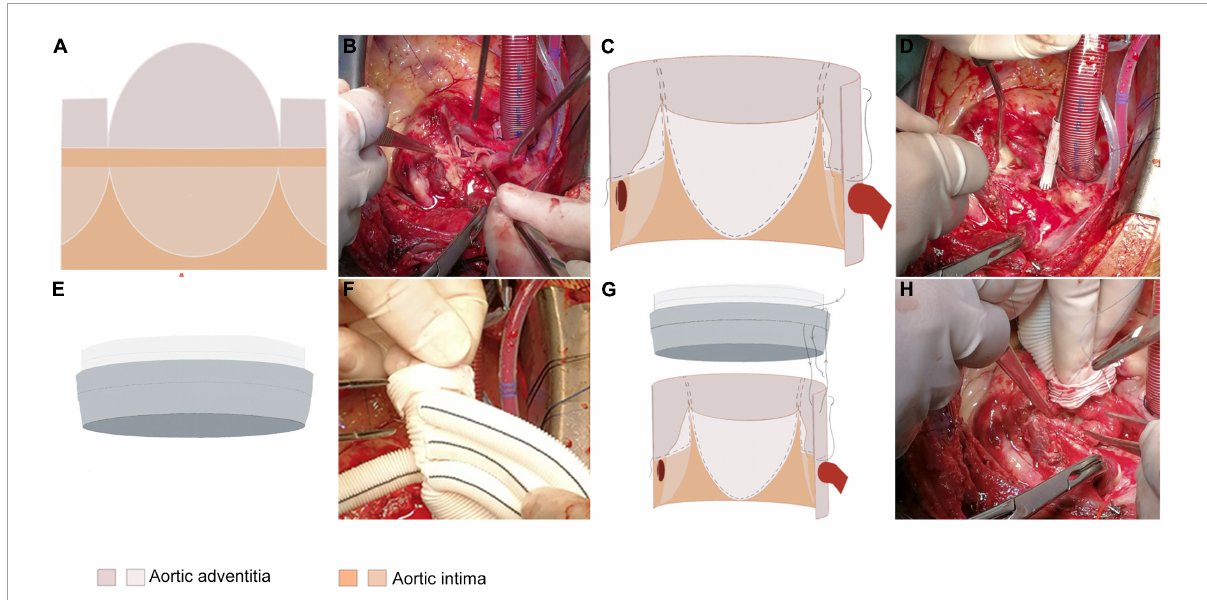
FIGURE1 The extended adventitial inversion suture and graft eversion anastomosis technique. (A,B) Only the aortic intima is transected 0.5 cm above the STJ while leaving the aortic adventitia intact. The reserved aortic adventitia is cut along the three valve junctions longitudinally along the aortic axis to the edge of the transected aortic intima. The shape of the aortic adventitia is trimmed according to the shape of the three aortic sinuses such that it inverses toward the base of the sinus with the non-coronary sinus reaching the base of the sinus and the left/right coronary sinuses reaching the upper edge of the coronary ostia. (C,D) The trimmed aortic adventitia is inversed toward the three coronary sinuses and secured with 1–2 continuous sutures for fixation. (E,F) Eversion of the proximal end of the graft outwards by 1 cm. (G,H) Performing the vascular grafts eversion, insertion into the aortic lumen to align the edges of the two tubes, and suturing the vascular grafts to the aortic wall 1–2 times with an edge distance of 0.5